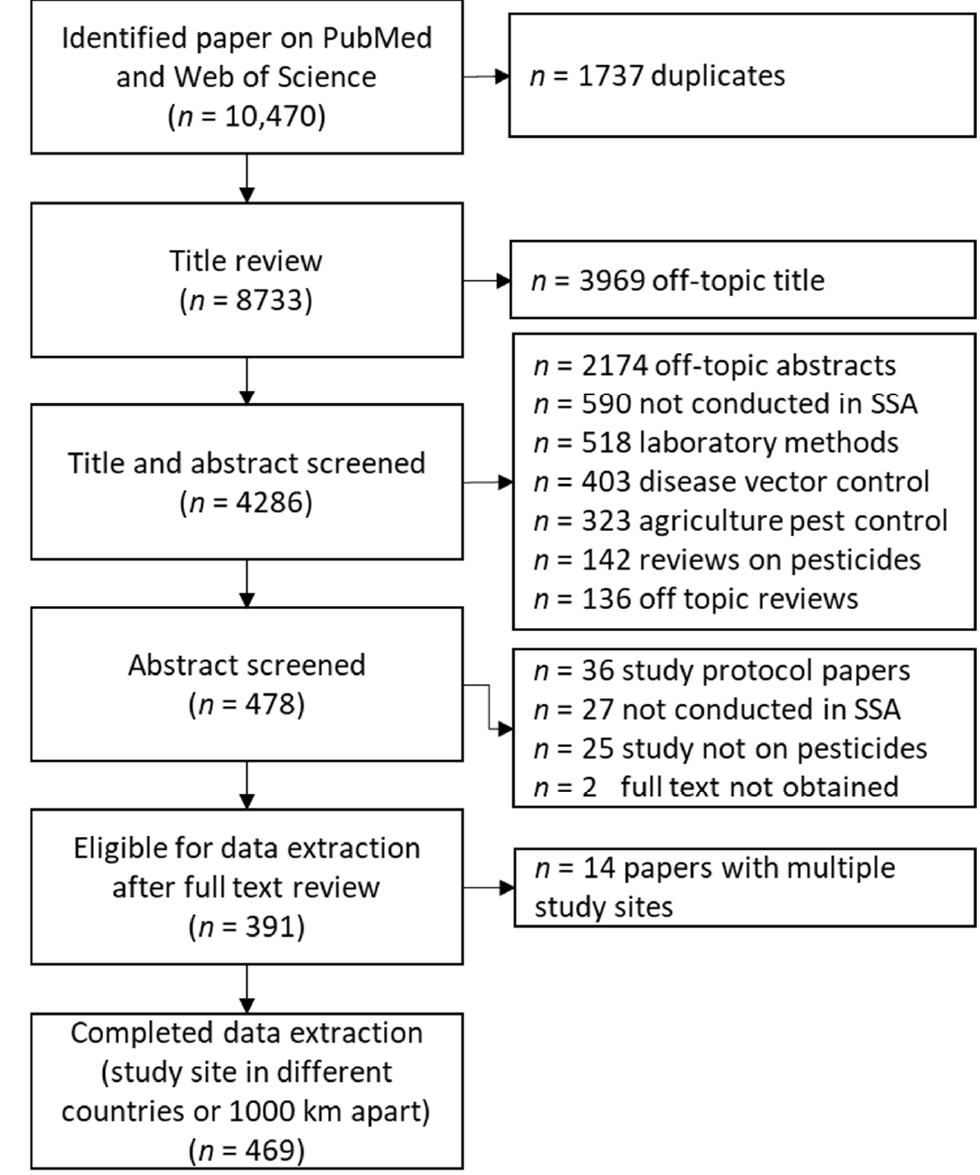
Figure 1. Flow chart indicating the number of articles hits during the literature review process, paper identification, and data extraction.